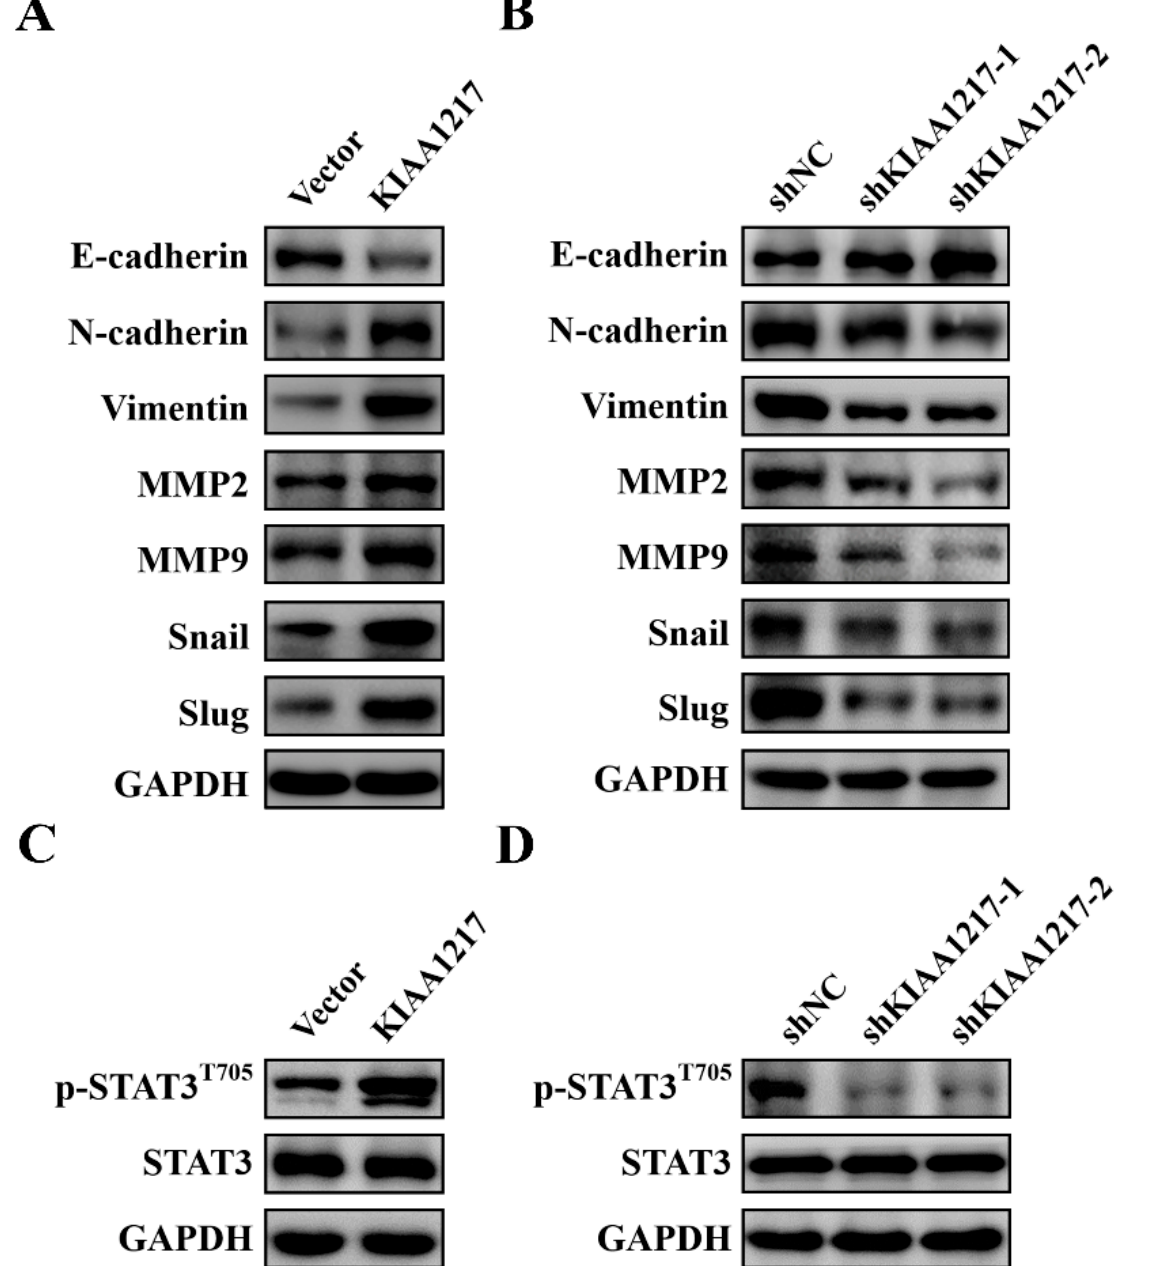
Figure 4. KIAA1217 induced EMT and activated STAT3 in HCC cells. ( A , B ) Western blot analysis of the expression of EMT markers in HepG2 cells with overexpression ( A ) or silencing of KIAA1217 ( B ). ( C , D ) Western blot analysis of the levels of phospho-STAT3 in HepG2 cells with overexpression ( C ) or knockdown of KIAA1217 ( D ). GAPDH was used as a loading control. 2.4. KIAA1217 Induces EMT by Activating STAT3 in HCC Cells We adopted two strategies to determine whether KIAA1217 induces EMT to promote HCC cell migration and invasion via STAT3 activation: downregulating STAT3 in HepG2 cells with KIAA1217 overexpression or activating STAT3 in HepG2 cells with KIAA1217 silencing. The siRNA targeting STAT3 was utilized to inhibit STAT3 in HepG2 cells over- expressing KIAA1217. Wound-healing and Transwell migration assays indicated that STAT3 knockdown significantly reduced the migration of HepG2 cells overexpressing KIAA1217 (Figure 5A,B). Similarly, a cancer cell spheroid invasion assay in a 3D setting